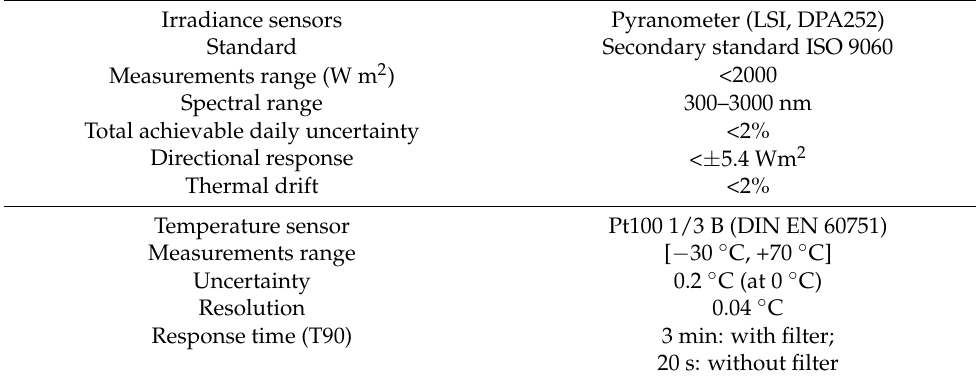
Table 2. Detailed characeristics of weather